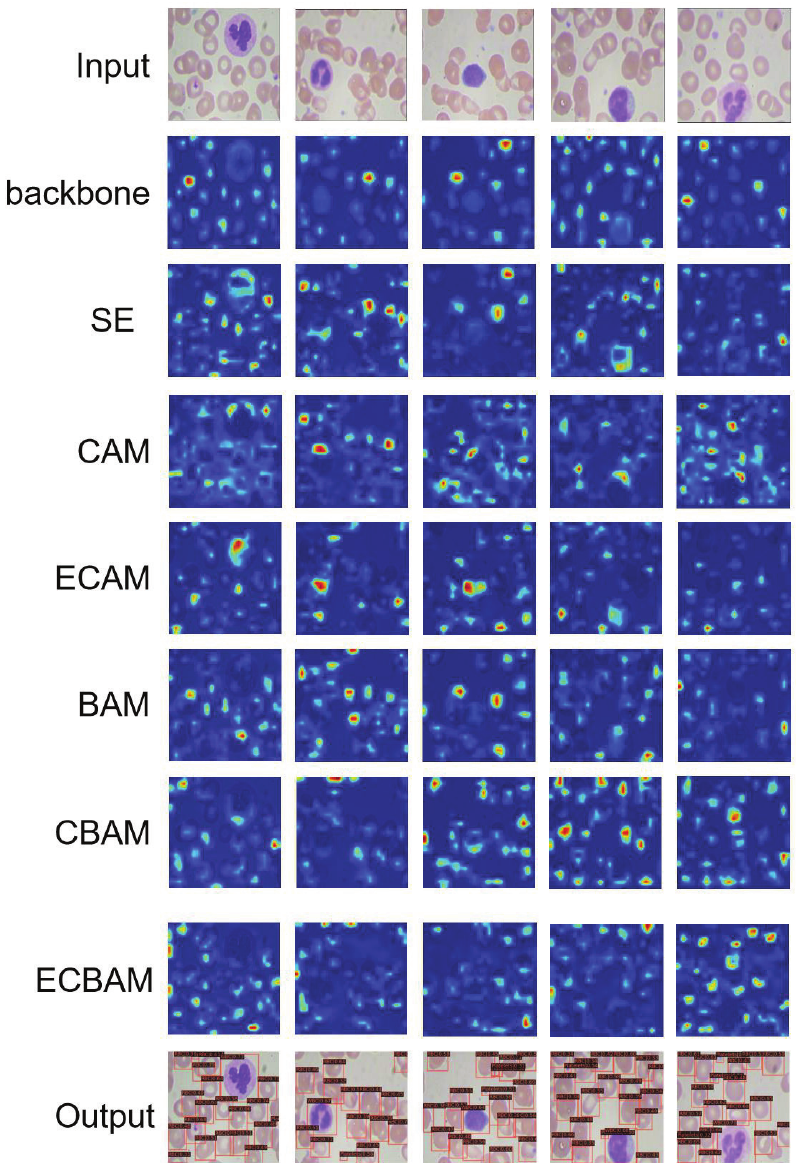
Figure 2. Attention map results on BCCD test set. Top to bottom: input images; the attention maps generated after backbone; the visualization results after the selected attention mechanisms, such as SE, and CAM in CBAM, ECAM, BAM, CBAM, ECBAM, and so on; the detection results of input images. The visualization is calculated after the selected